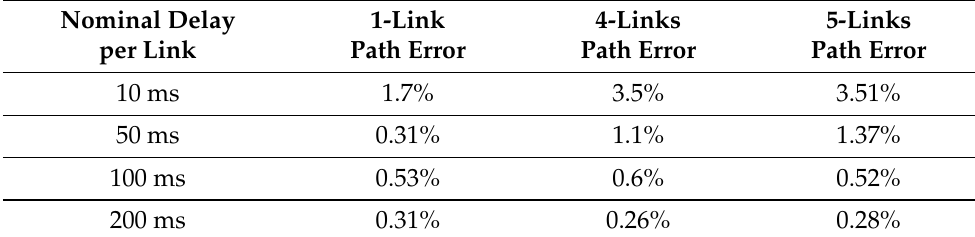
Table 3. Multi-link path performance